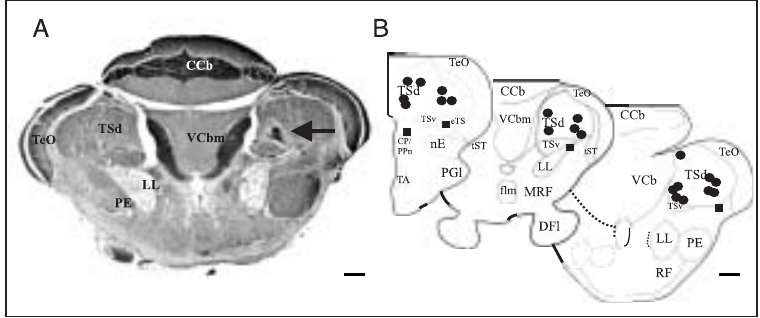
Figure 5. A , Photomicrograph of a frontal section of the mesencephalon of a representative fish showing the electrolytic lesion placed at the injection site into the torus semicircularis dorsalis (TSd) (arrow). Scale bar = 500 µm. B , Schematic drawings of frontal sections of the mesencephalon of Gymnotus carapo , showing the TSd and associated brain structures. Circles indicate the location of sites inside the TSd in which microinjections of bicuculline elicited motor and electromotor responses. The number of points in the figure is less than the total number of fish used because of several overlaps. Squares indicate the location of sites outside the TSd that were unresponsive to the drug. Scale bar for drawing = 650 µm. CCb = corpus cerebelli; CP/PPn = central-posterior/prepacemaker complex; DFl = nucleus diffusus lateralis of inferior lobe; eTS = torus semicircularis efferents; flm = fasciculus longitudinalis medialis; LL = lateral lemniscus; nE = nucleus electrosensorius; MRF = mesencephalic reticular formation; PE = periglomerular nucleus; PGl = preglomerular nucleus, lateral subdivision; RF = reticular formation (rhombencephalon); TA = nucleus tuberis anterior; TeO = optic tectum; TSd = torus semicircularis dorsalis; tST = subtectal tract; TSv = torus semicircularis ventralis; VCb = valvula cerebelli; VCbm = valvula cerebelli pars